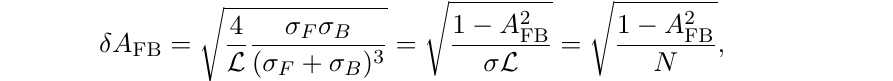
Figure 4 . Distribution in the invariant mass M ‘‘ of the lepton pair produced in SM and SSM NC Drell-Yan processes at the HL-LHC (left panel). The dashed lines represent events with cos θ and cos θ < 0 , and the solid areas are associated with the spectra obtained after the implementation ‘ − of various | y ‘‘ | cuts. Corresponding true and reconstructed forward-backward asymmetries are shown in the right panel of the figure. We refer to the text for more